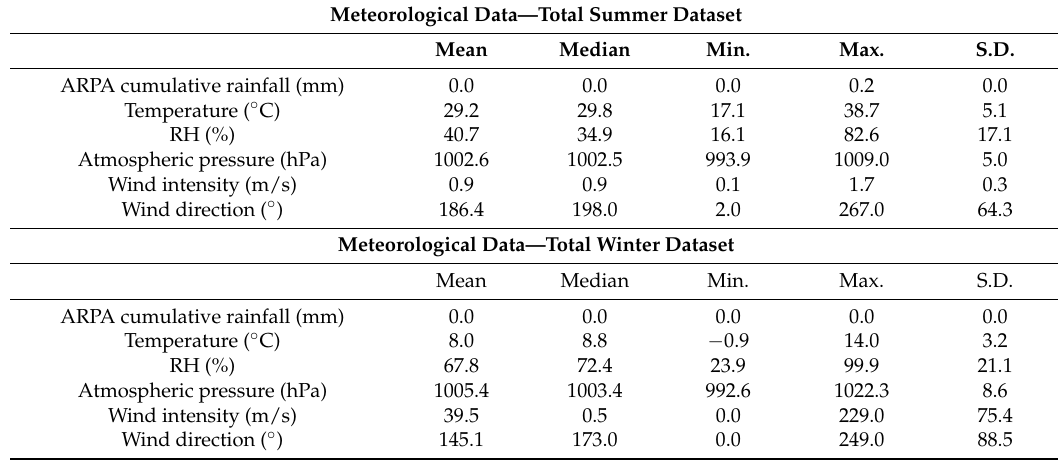
Table 3. Meteorological parameters at the sampling site during the two monitoring periods. N: number of data used in statistical analysis; Min: minimum; Max: maximum; S.D.: standard